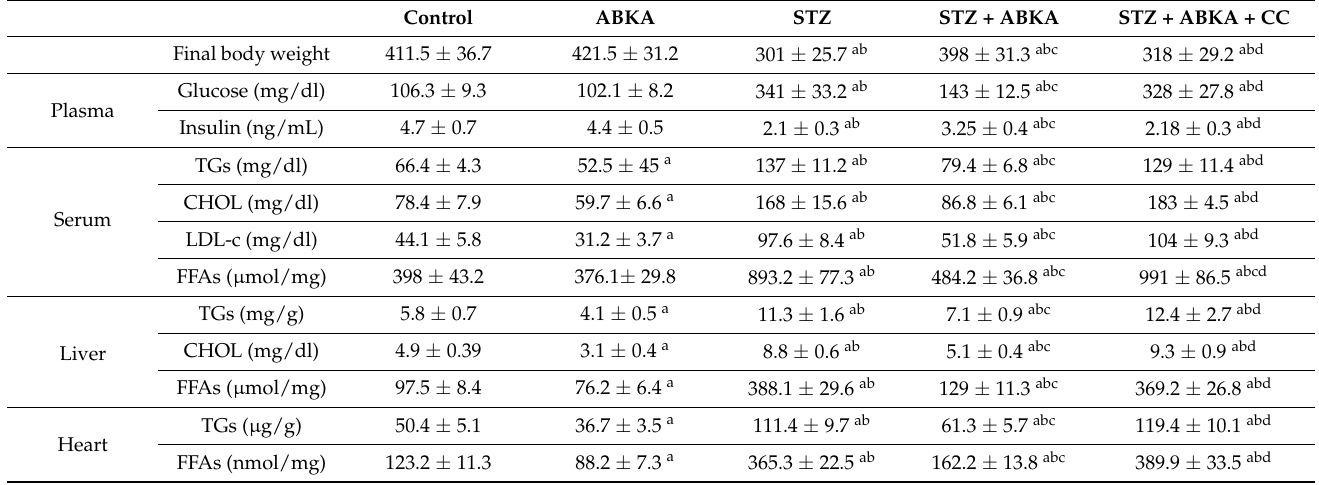
Values are presented as mean ± SD (n = 8/group). Data were considered significantly different at p < 0.5. a: signif- icantly different as compared to control rats; b: significantly different as compared to AKBA-treated rats; c: signifi- cantly different as compared to STZ-diabetic rats; d: significantly different as compared to STZ + AKBA-treated rats. CC–compound C (a selective AMPK